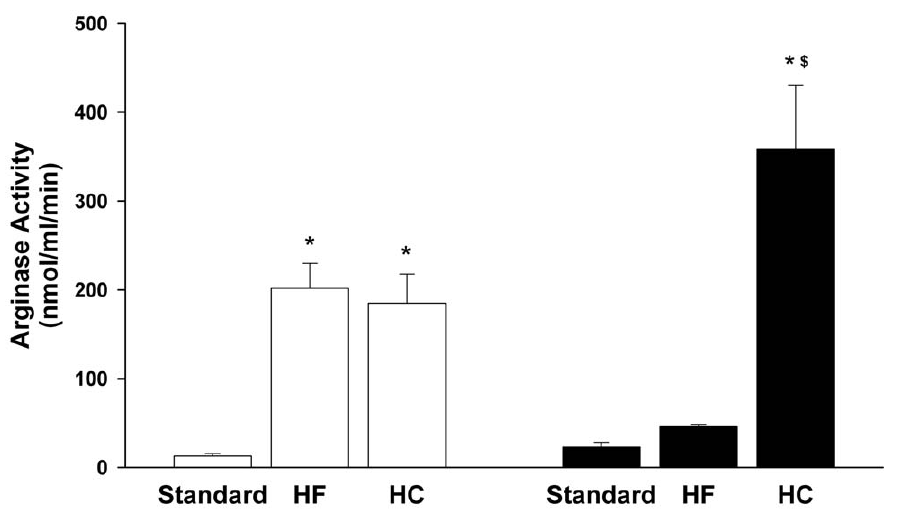
doi:10.1371/journal.pone.0015253.g001